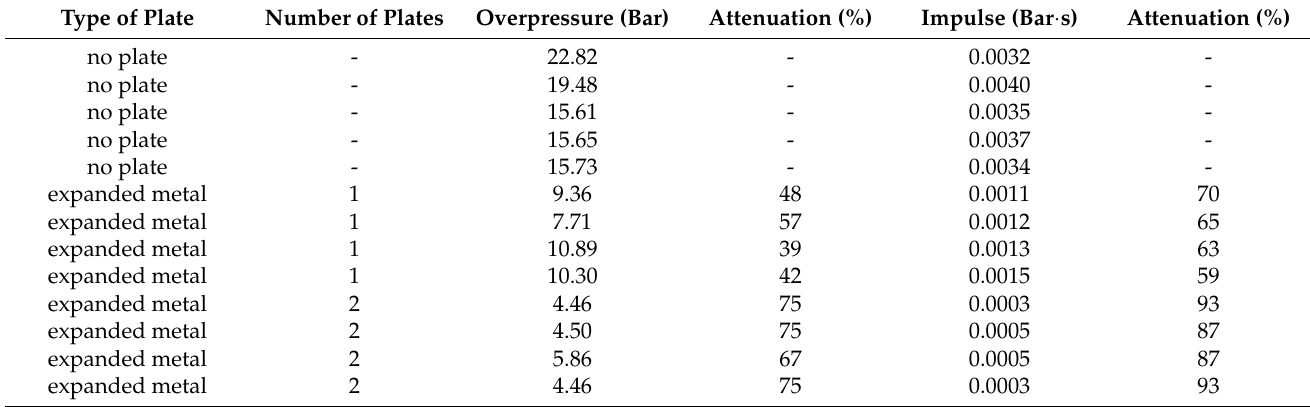
Figure 12. Reflected pressure ( a ) and impulse ( b ) measured on the wall positioned 50 mm behind either one or two expanded metal plates. One reference test, which was performed without plates, is also shown. Table 1. Initial reflected overpressure and maximum impulse collected by the sensor inserted in the wall and located 50 mm downstream from the perforated plates for all experiments. The difference from the mean value obtained with the reference tests (no plate) is also given.